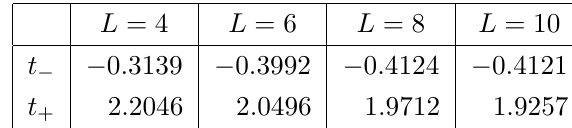
Figure 3 . Plot of branches A , B , C and D corresponding to the e(cid:11)ective tachyon potential at levels ( L; 3 L ) with L =4,6 and 8, in Schnabl gauge.